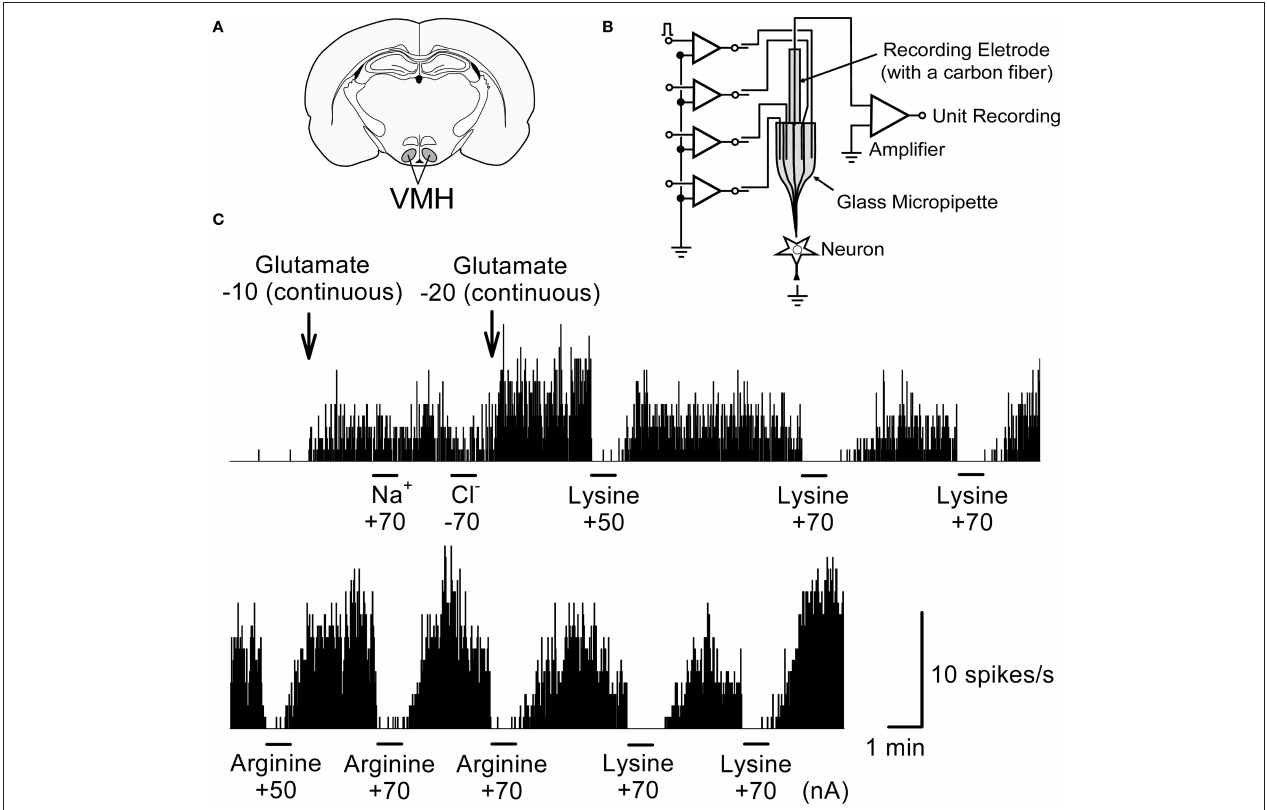
FIgure 8 | An example of inhibitory responses to lysine and arginine applied microiontophoretically on glutamate-induced single unit activity in a rat VMH neuron. (A) The position of VMH in the rat brain. (B) A schematic representation of the multi-barreled glass micropipette with a recording electrode. (C) Suppression of glutamate-induced activity by lysine and arginine. Firing rate of this neuron was little at the basal level; therefore glutamate ( − 10 or − 20 nA) was applied continuously in the background to evoke steady-state levels of firing activity. Microiontophoretic applications (45 s) of either lysine or arginine did inhibit this glutamate-induced neuronal